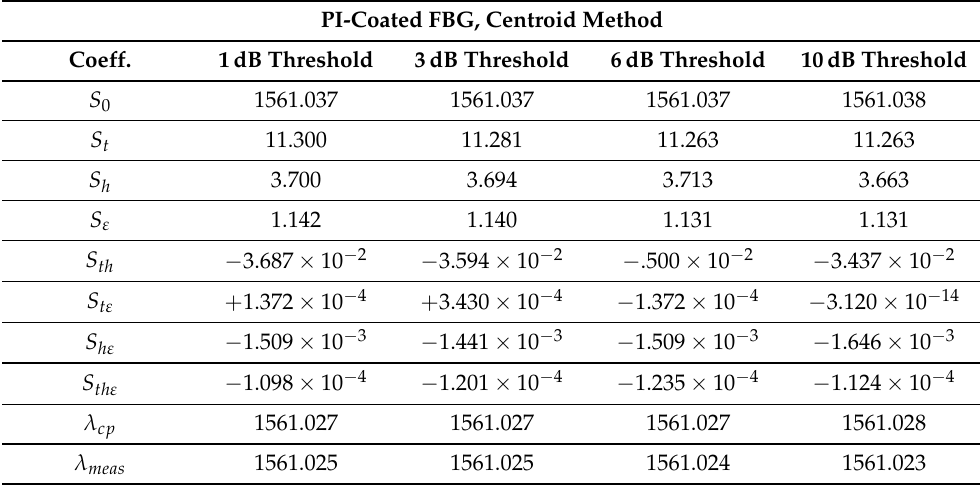
Table 4. Main and cross sensitivities of PI-coated FBG, calculated using factorial design in a centroid detecting algorithm within two thresholds.